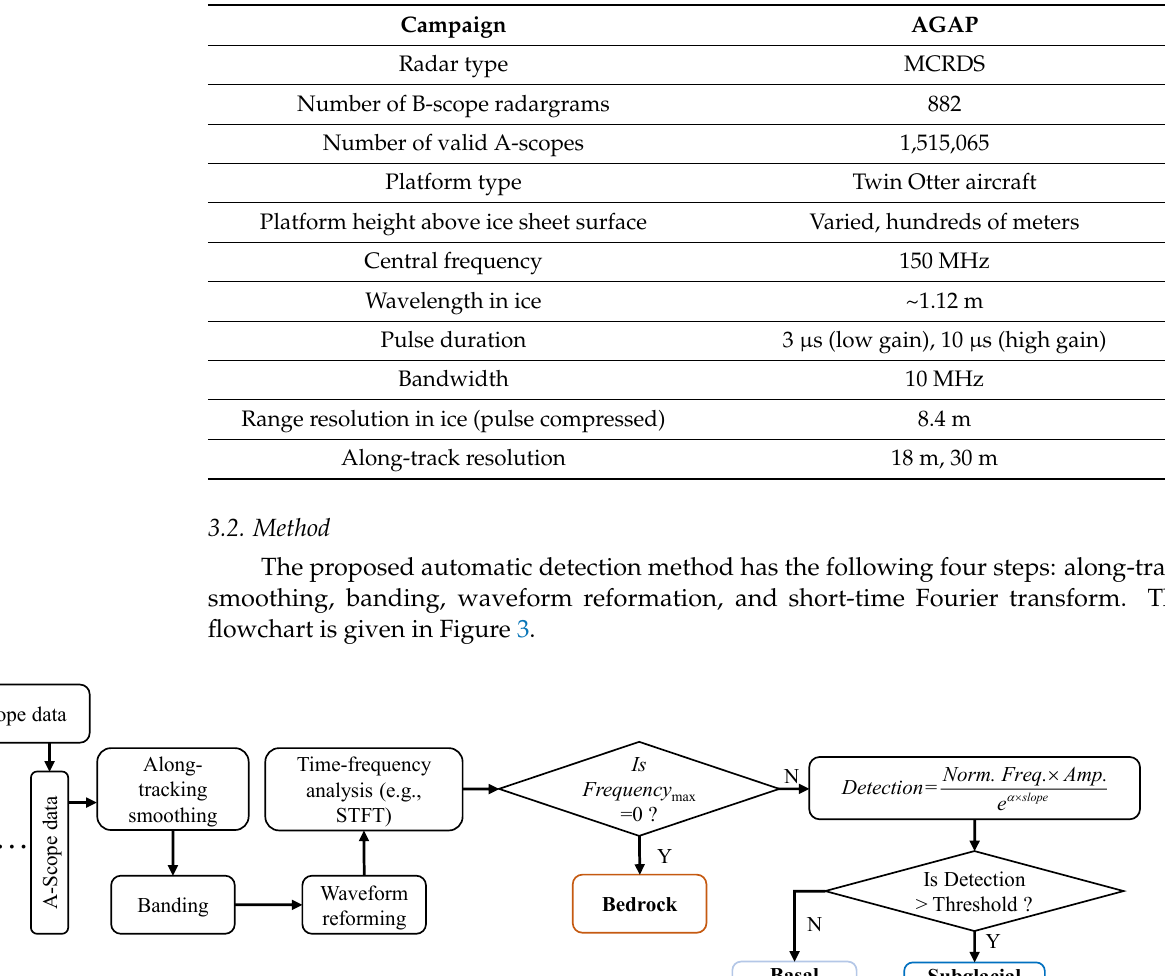
Table 1. Parameters of the RES system for the AGAP region.